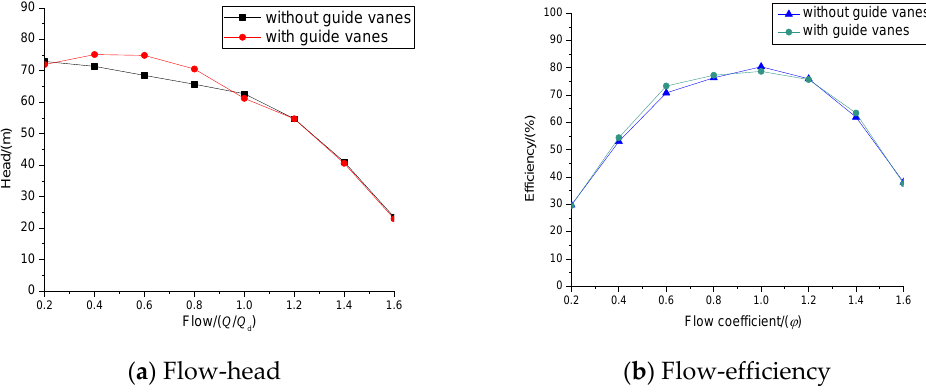
Figure 17. External characteristic curve of centrifugal pump.